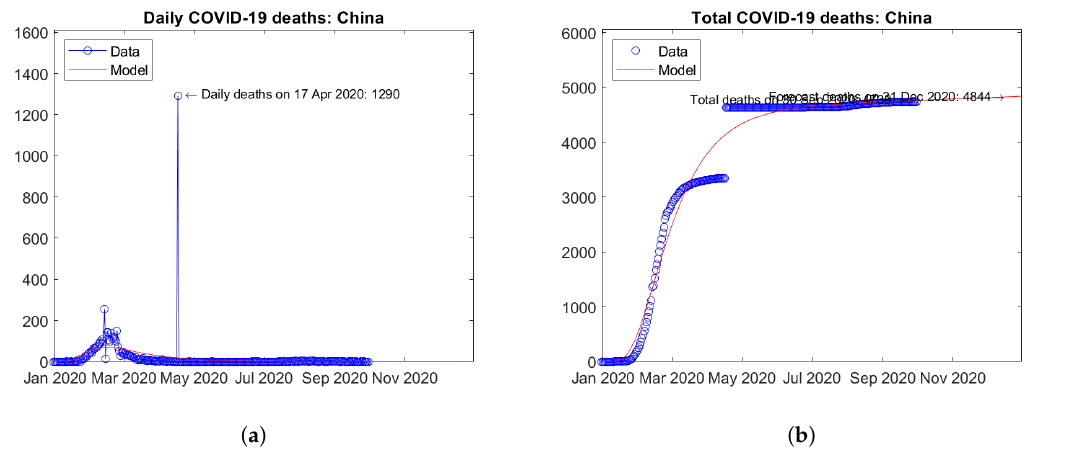
Figure 4. Actual and predicted trends in China: ( a ) daily deaths, ( b ) total deaths.